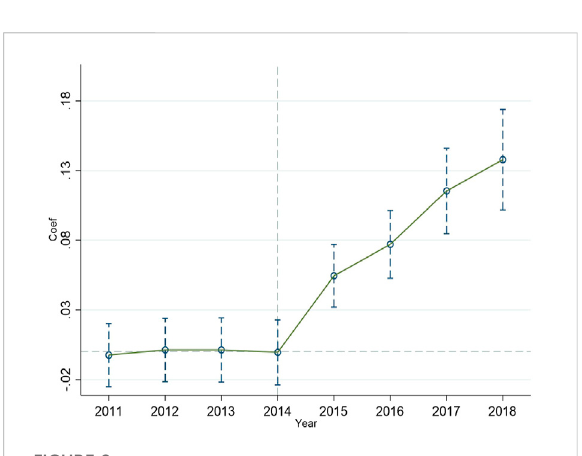
FIGURE 2 Parallel trend test of advanced industrial structure.